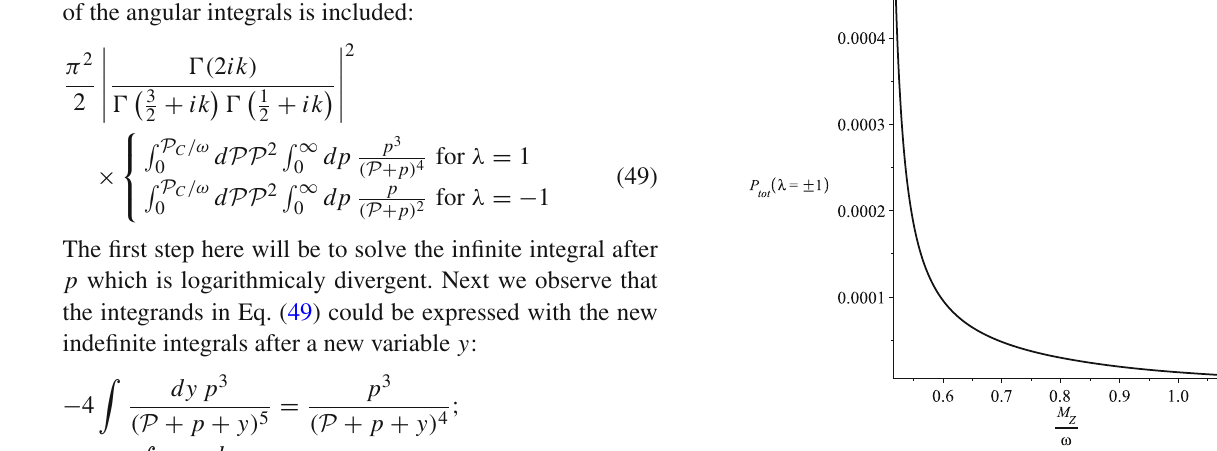
Fig. 9 P tot (λ = ± 1 ) as a function of parameter M Z /ω